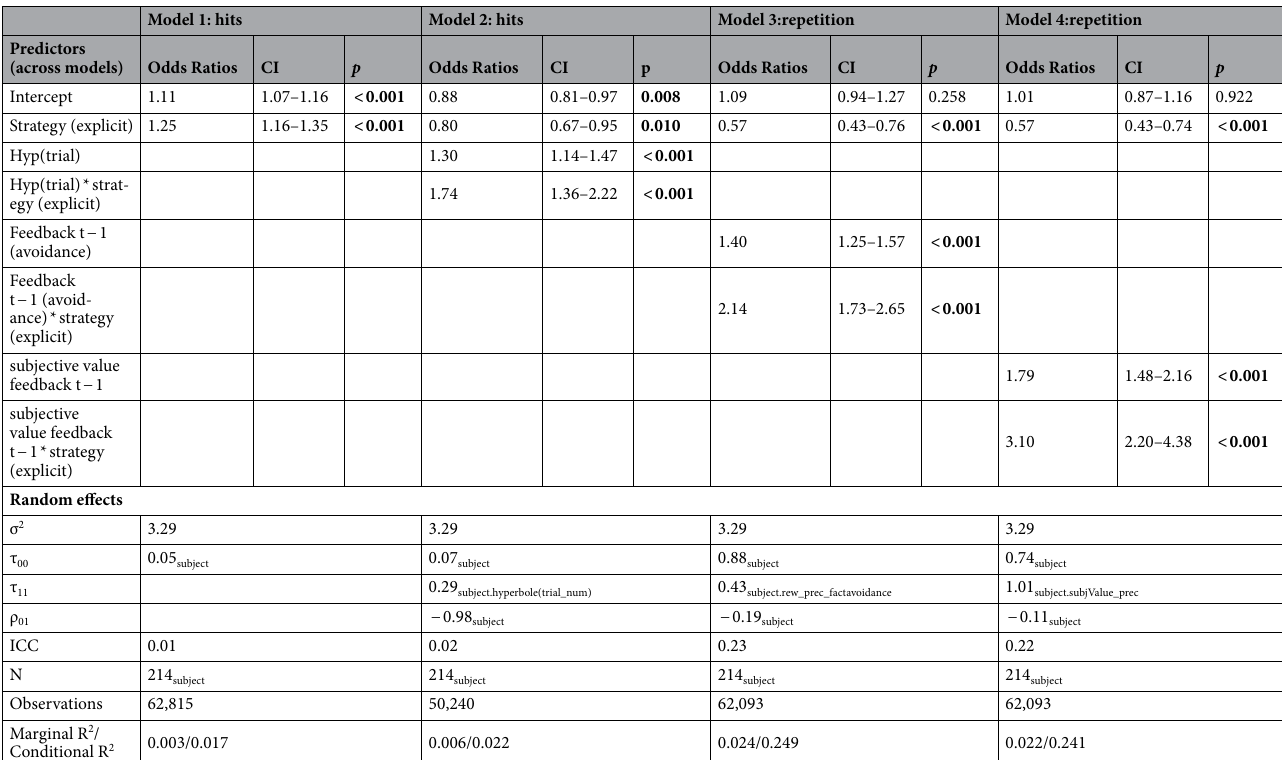
Table 2. Mixed logistic models. Controlling for the effect of having an explicit strategy. Random effects: σ 2 = Residual variance, τ 00 = random intercept variance, τ 11 = random slope variance, ρ 01 = random intercept/ slope correlation, ICC = Intraclass Correlation Coefficient. Significant values are in